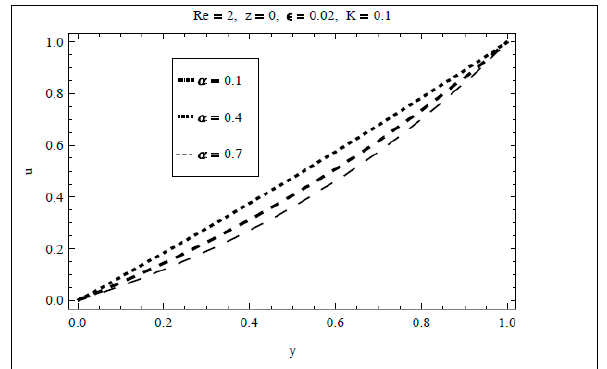
Figure 2. Effect of α on main flow velocity u along y .